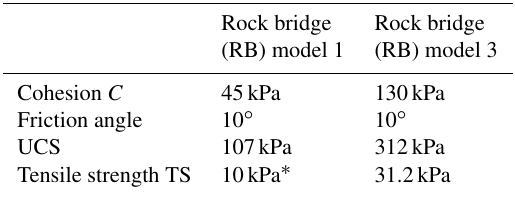
Table 4. Mechanical characteristics of rock bridges in model 3 used when studying the effect of tensile strength. The dip angle is equal to 80 ◦